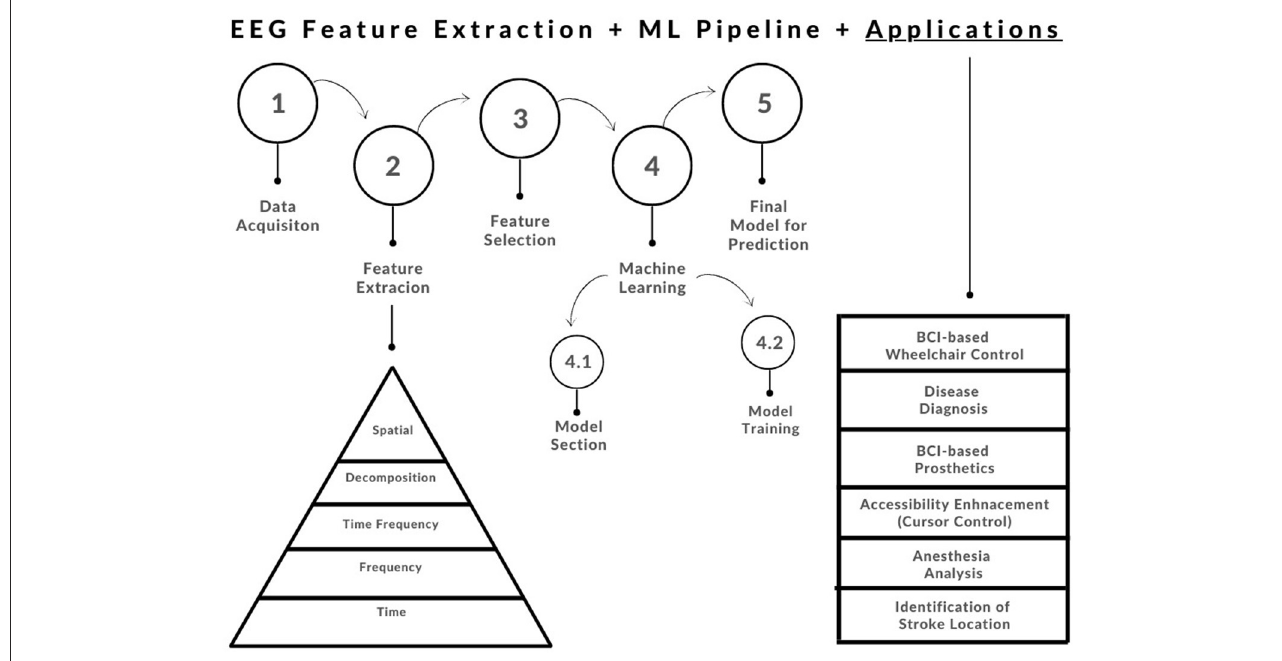
FIGURE2 Basic feature extraction and machine learning pipeline showing the evolution of biomedical signal feature extraction techniques (Subasi,